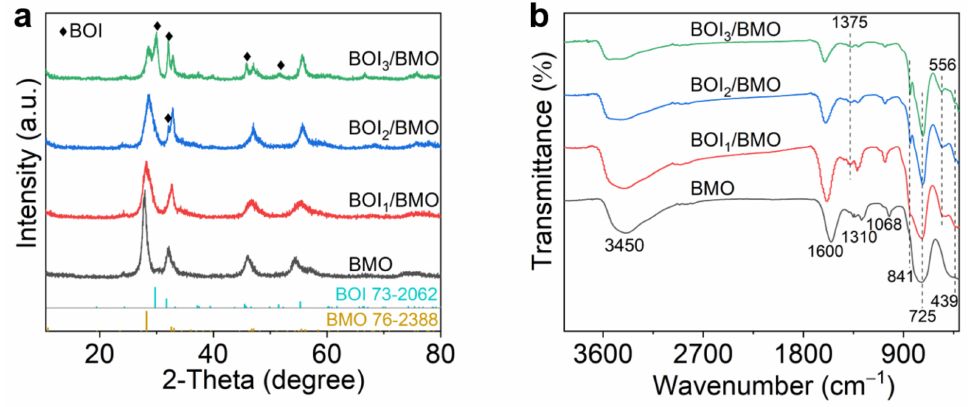
Figure 1. ( a ) XRD and ( b ) FTIR spectra of BMO, BOI 1 /BMO, BOI 2 /BMO, and BOI 3 /BMO. Fourier transform infrared (FTIR) spectra of pure BMO and BOI 1–3 /BMO all